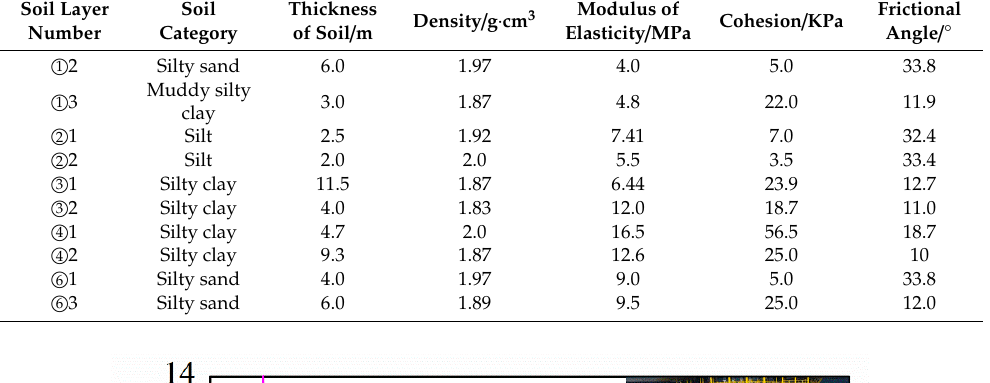
Table 2. The characteristic parameters of the soil layer.